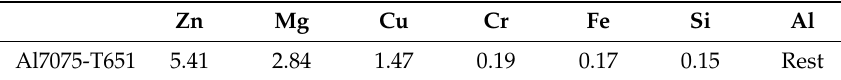
Table 3. Chemical composition of